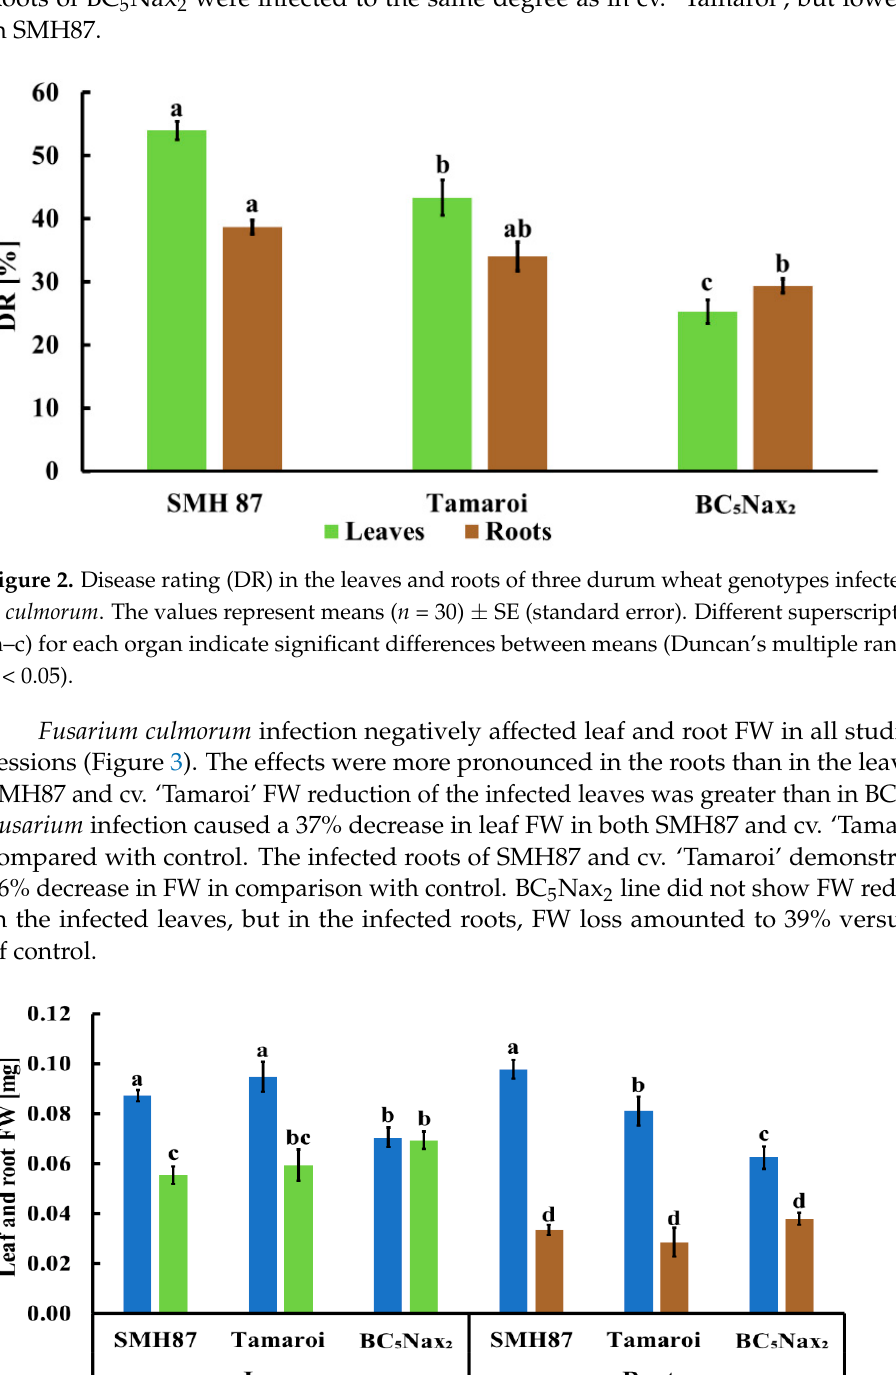
Figure 4 . Effect of F. culmorum infection on the content of ( A ) chlorophyll a , b (Chl a , b ) and carotenoids (Car), (B) total water-soluble carbohydrates (TSC), ( C ) total soluble phenolics (TSP), ( D ) cell wall-bound phenolics (CWP) in the leaves and roots of three durum wheat accessions. The values represent means ( n = 30) ± SE. Different superscript letters (a–h) for each organ indicate significant differences between means (Duncan’s multiple range test; p < 0.05). 2.1.3. Total Soluble Carbohydrates (TSC)